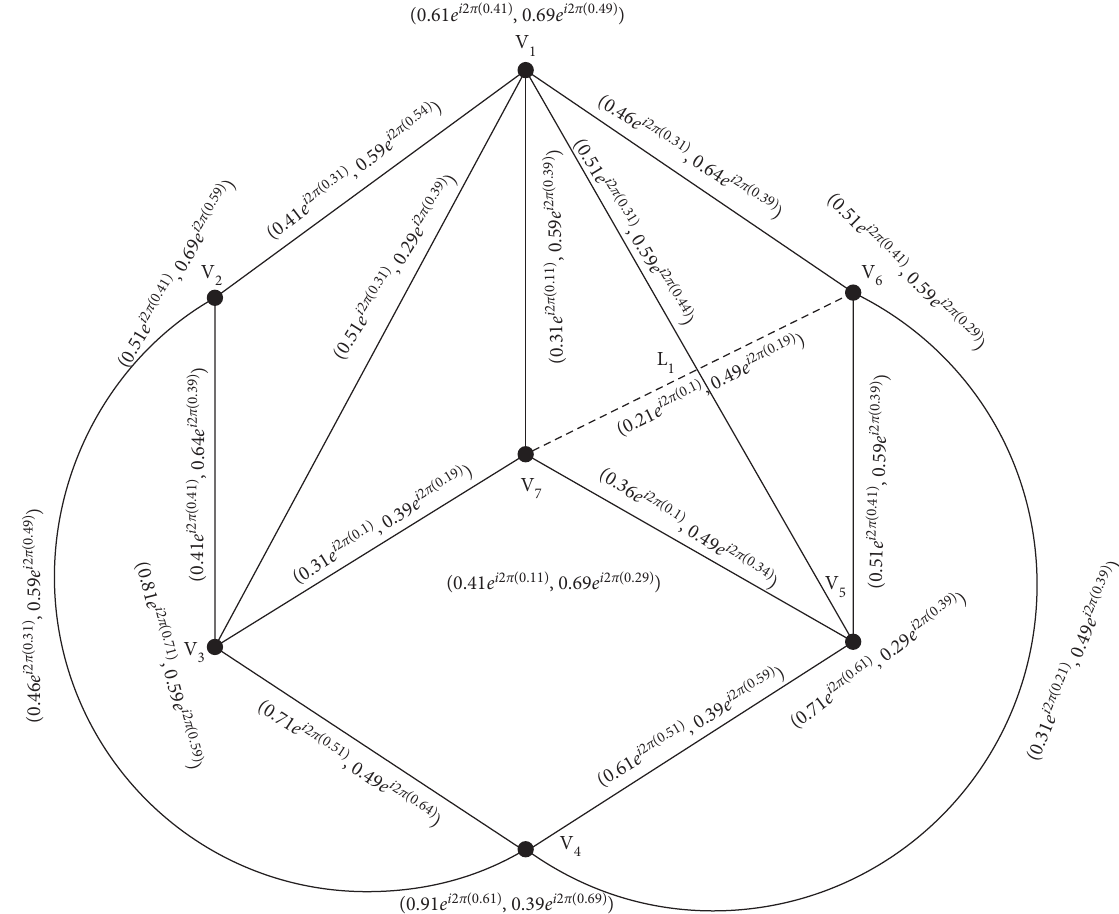
Figure 14: Complex q-rung orthopair fuzzy electric connection